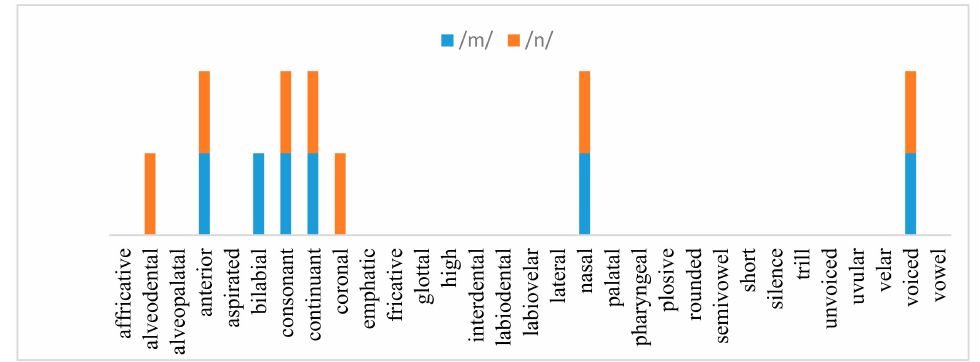
Figure 1. AFs of the two Arabic phonemes/m/and/n/. AF with no bar means this feature is absent in the two